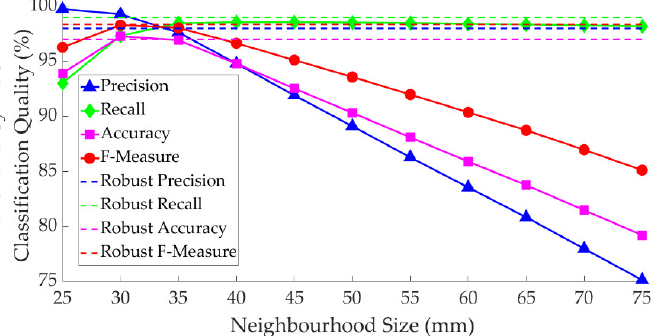
Figure 13. Quality of point-to-model designation using Algorithm 2 vs. the neighborhood size.